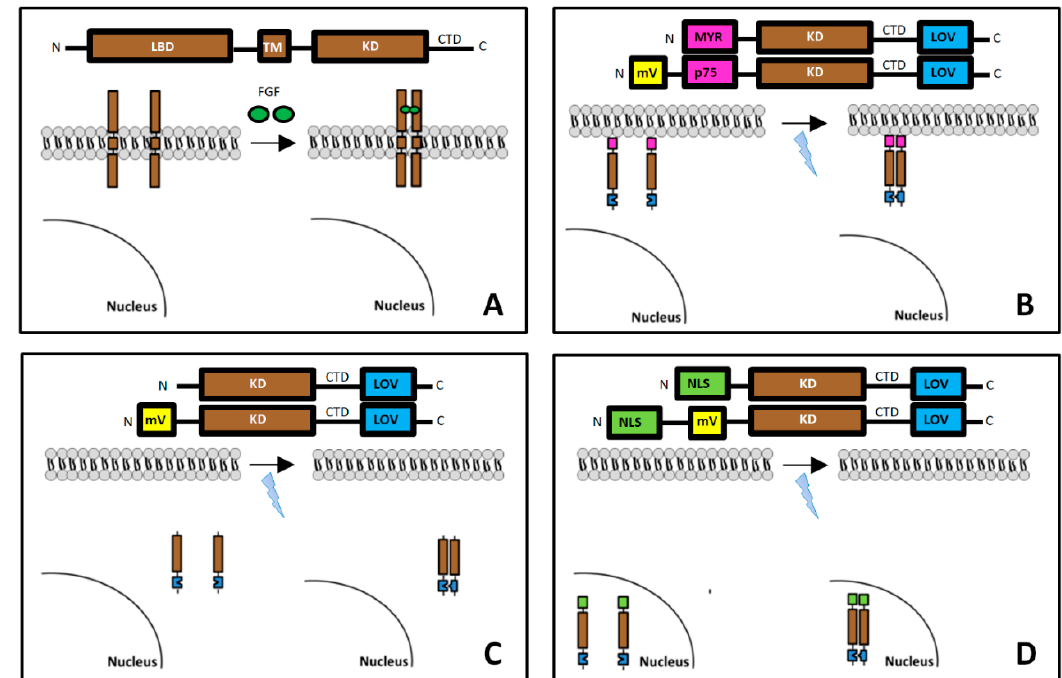
Figure 1. Design of light-controlled opto-fibroblast growth factor receptors (FGFR1s) and their molecular architecture: sequence of the different FGFR1 coding genes, spatial relation of FGFR1s to the surface membrane and nucleus, and their activation/dimerization. ( A ) Naturally occurring full-length FGFR1 consists of the extracellular ligand-binding (LBD), transmembrane (TM), kinase (KD) and C-terminal tail (CTD) domains. ( B ) Artificial mem-opto-FGFR1 is anchored to the plasma membrane with an N-terminal myristoylation signal (MYR) followed by the KD, CTD and LOV domain (mV-mem-opto-FGFR1 is inserted into the plasma membrane by incorporation of the transmembrane domain of p75). Fluorescent mVenus and the light-oxygen-voltage-sensing (LOV) protein are separated to avoid non-specific activation of the LOV domain by mVenus (by Förster resonance energy transfer). mVenus can be detected by excitation with green light (514 nm) that does not activate the LOV domain. ( C ) Cyto-opto-FGFR1 consists of only the KD and the LOV domain. ( D ) Three nuclear localization sequence (NLS) signals are inserted into nucl-opto-FGFR1 with or without mVenus.